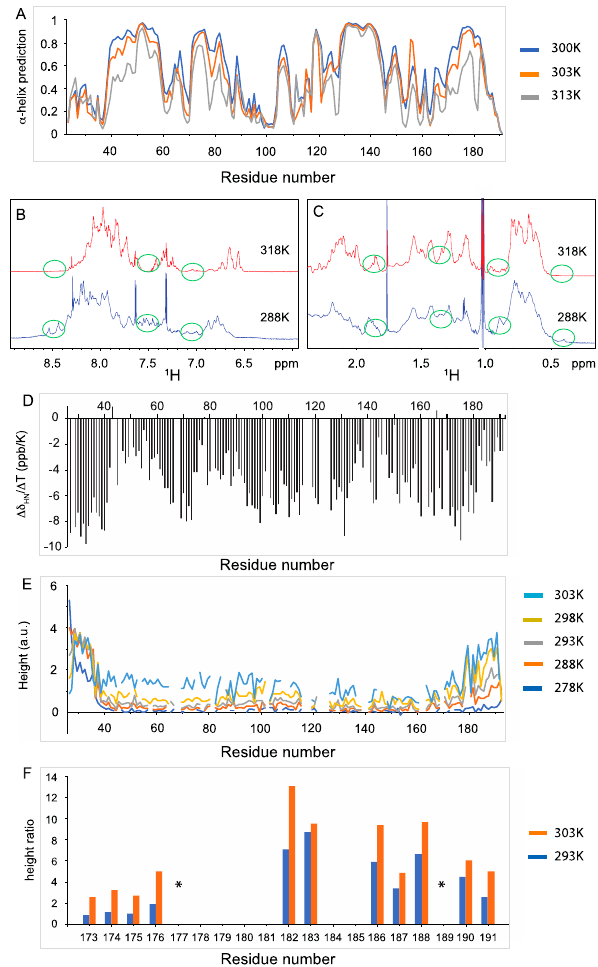
Figure 3. Flexibility and helix propensity of Nter-BsRNaseY amino acids, as deduced from the 1 H- 15 N- 13 C NMR data. ( A ) Prediction of α -helices propensity by TALOS, derived from the backbone NMR chemical shifts at 300K (in blue), 303K (in orange), and 313K (in grey). Comparison of the amide and aromatic ( B ) and aliphatic protons ( C ) in the 1D NMR spectra recorded at 288K (in blue) and 318K (in red). The green circles highlight the highest differences observed in the chemical shifts at the two temperatures. ( D ) Temperature coefficients ( ∆ δ HN/ ∆ T (ppb/K)). ( E ) 1 H- 15 N TROSY peak heights (arbitrary units) at 278, 288, 293, 298, and 303K. The peak heights for residues 170 to 192 are the sum of the corresponding duplicated peaks in the 1 H- 15 N TROSY spectra. ( F ) Comparison of the peak height ratio in the 1 H- 15 N BEST-TROSY spectra of pairs of duplicated peaks for several residues located in the 173–191 segment at 293K (in blue) and 303K (in orange). The peaks in Figure S7A,B were used to calculate the peak height ratios. * indicates that the peak height ratio could not be measured because the duplicated peaks of E177 and K189 are superimposed onto other